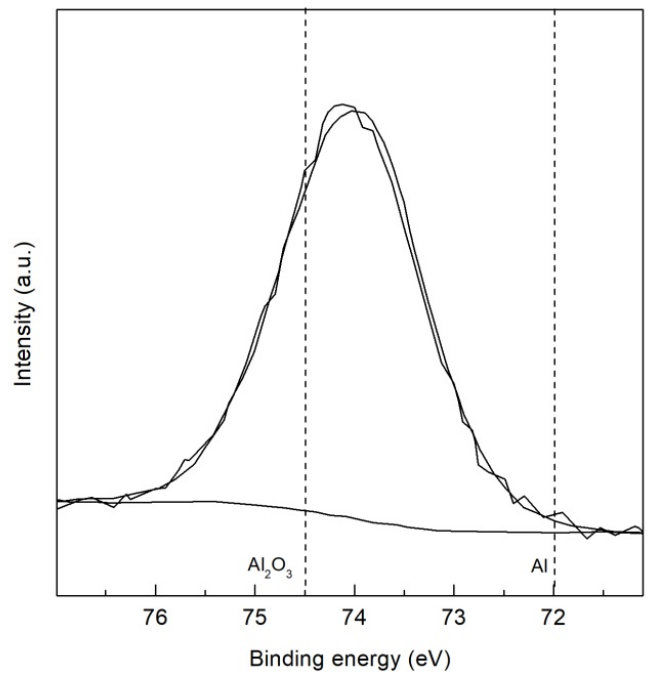
Figure 7. High resolution XPS spectra for Al 2p of TMP TWIP steel.